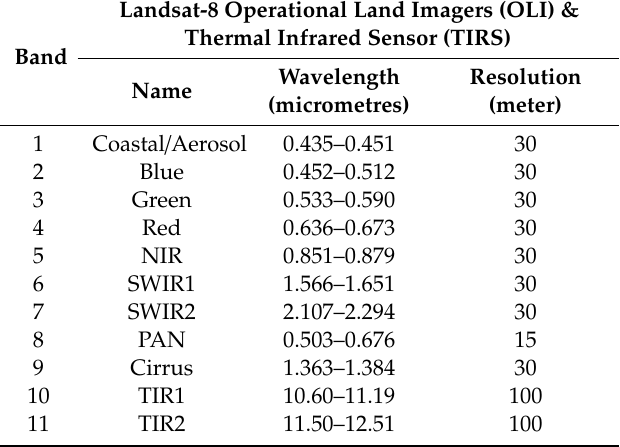
Table 1. A list of OLI and TIRS spectral bands of Landsat-8. Landsat-8 Operational Land Imagers (OLI) & Thermal Infrared Sensor (TIRS) Band Wavelength Resolution Name (micrometres) (meter) Coastal /